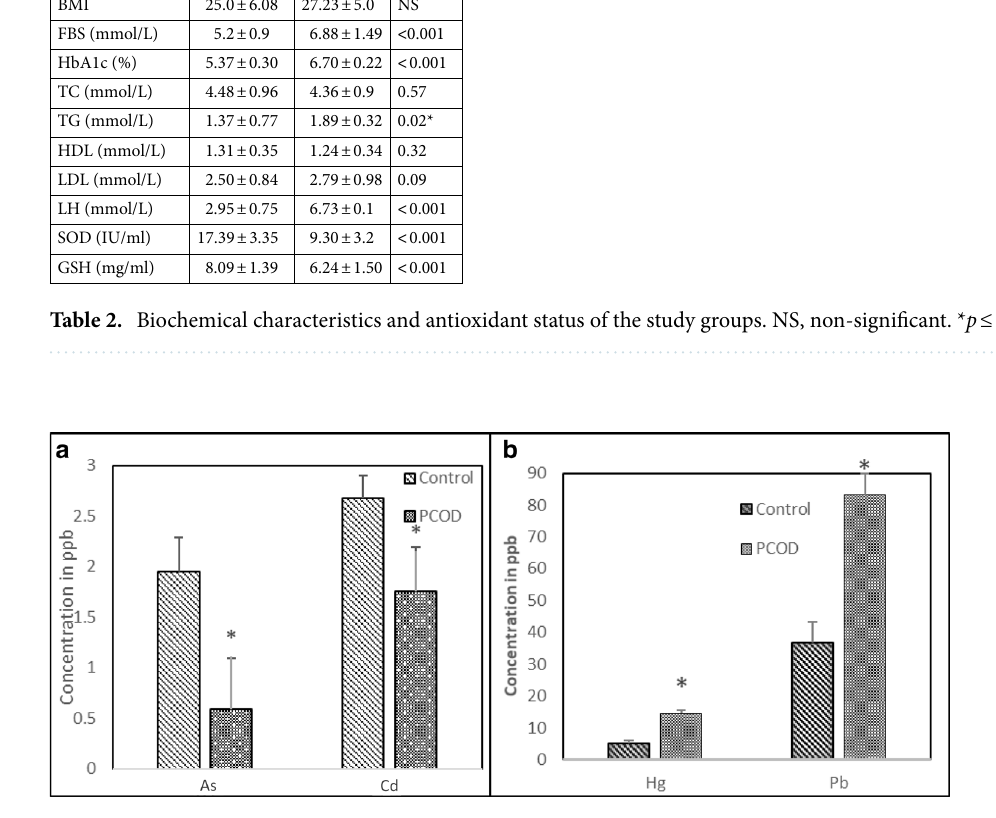
Figure 1. Serum concentrations of heavy metals in control and PCOS groups.